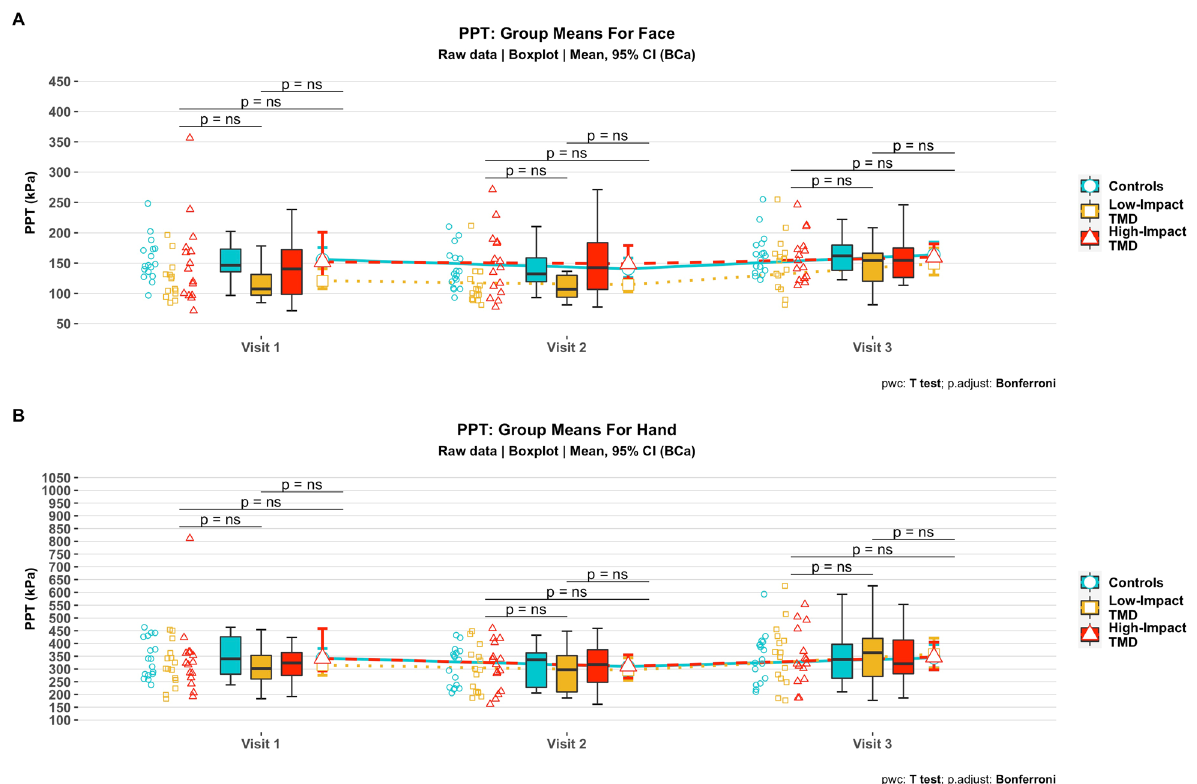
Figure 3. Pressure pain thresholds in the face ( A ) and hand ( B ) over time: group means. Symbols on the left represent raw data points per participant; boxplots show median and interquartile range. Group means are shown with error bars representing their respective bias-corrected and accelerated (BCa) bootstrapped 95% confidence